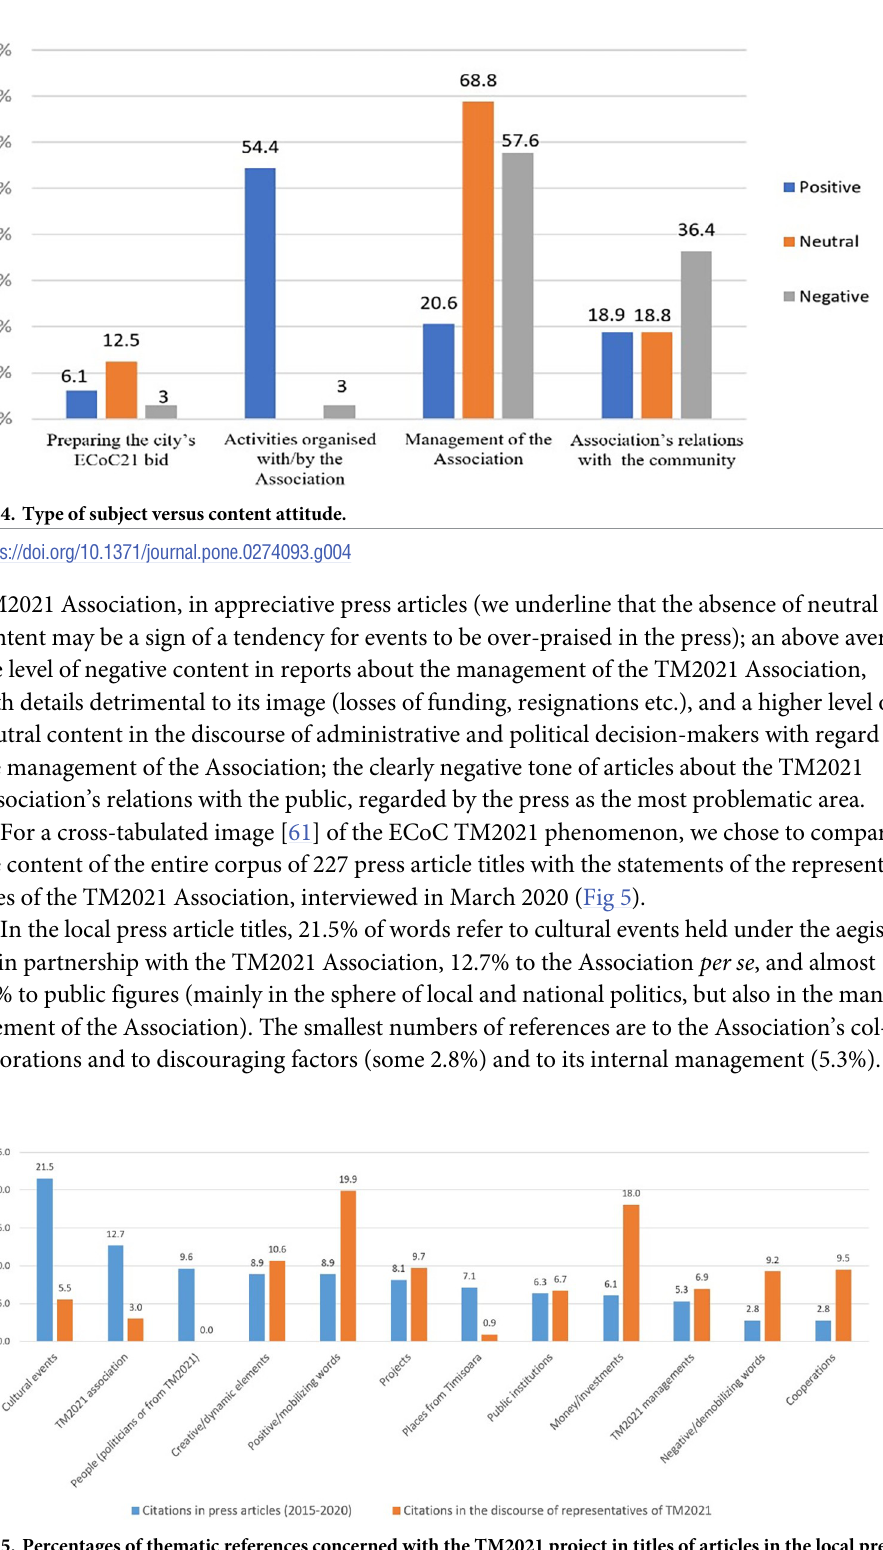
Fig 5. Percentages of thematic references concerned with the TM2021 project in titles of articles in the local press, 2015–2020, and in the discourse of representatives of the Association (interviewed March 2020).